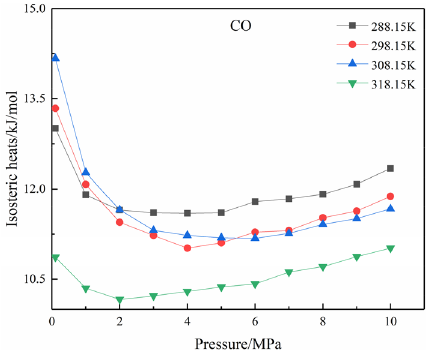
Figure 10. Adsorption isosteric heats of CO at 288.15–318.15